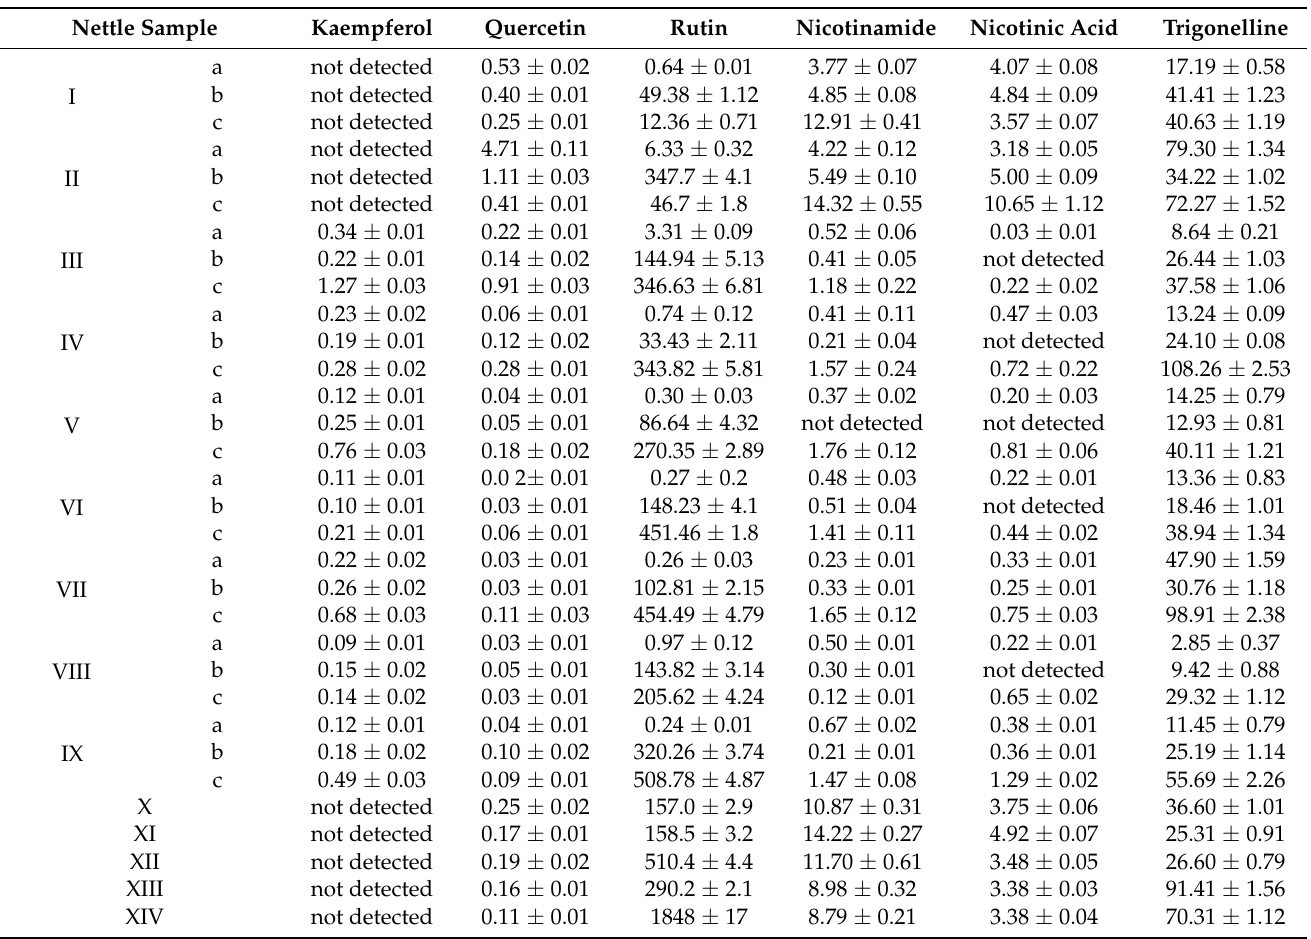
Table 5. Flavonols, vitamin B 3 and trigonelline content in nettle determined with the use of LC– MS/MS ( µ g g − 1 of fresh weight); samples I–IX: a—root; b—stem; c—leaves; X–XIV—aerial parts of